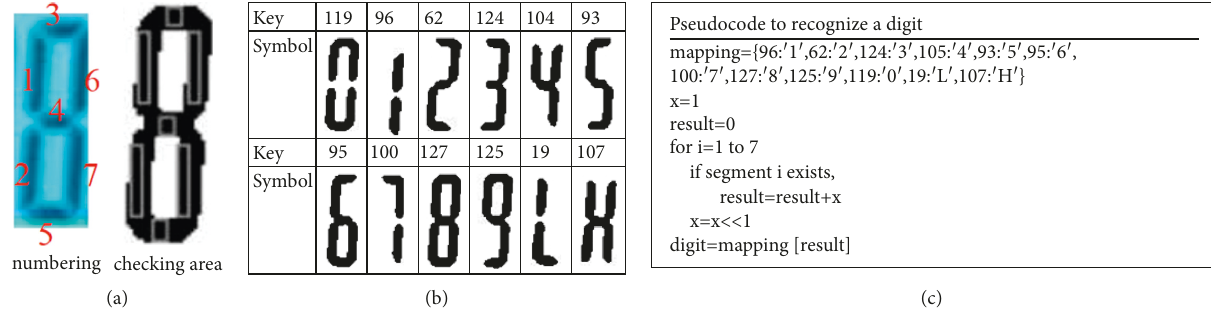
Figure 7: Illustration of seven-segment OCR: (a) the definitions of the segment numbers and the seven rectangular areas to be checked, (b) the mapping dictionary for each character, and (c) the pseudocode for digit